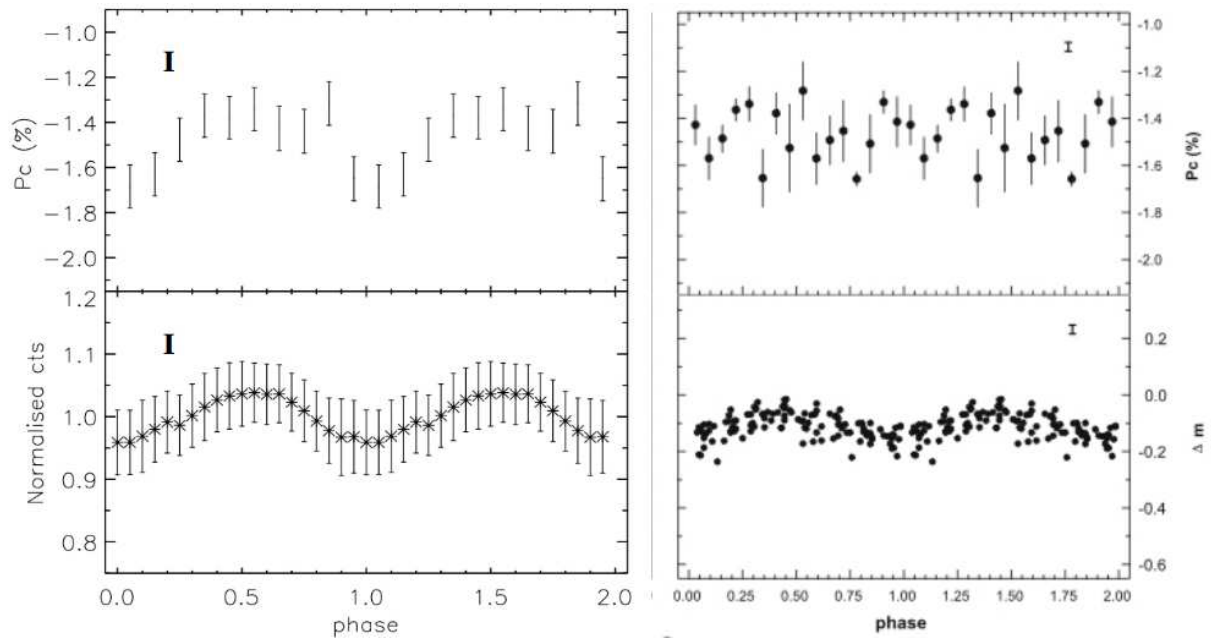
Figure 1: I-band photo-polarimetric observations of the intermediate polar NY Lup. Bottom and top panels are the phase-spin-folded photometry and circular polarization respectively. Left and right panels were made with the 1.9m of the SAAO and the VLT respectively. Figure reproduced from Potter et al. (2012).